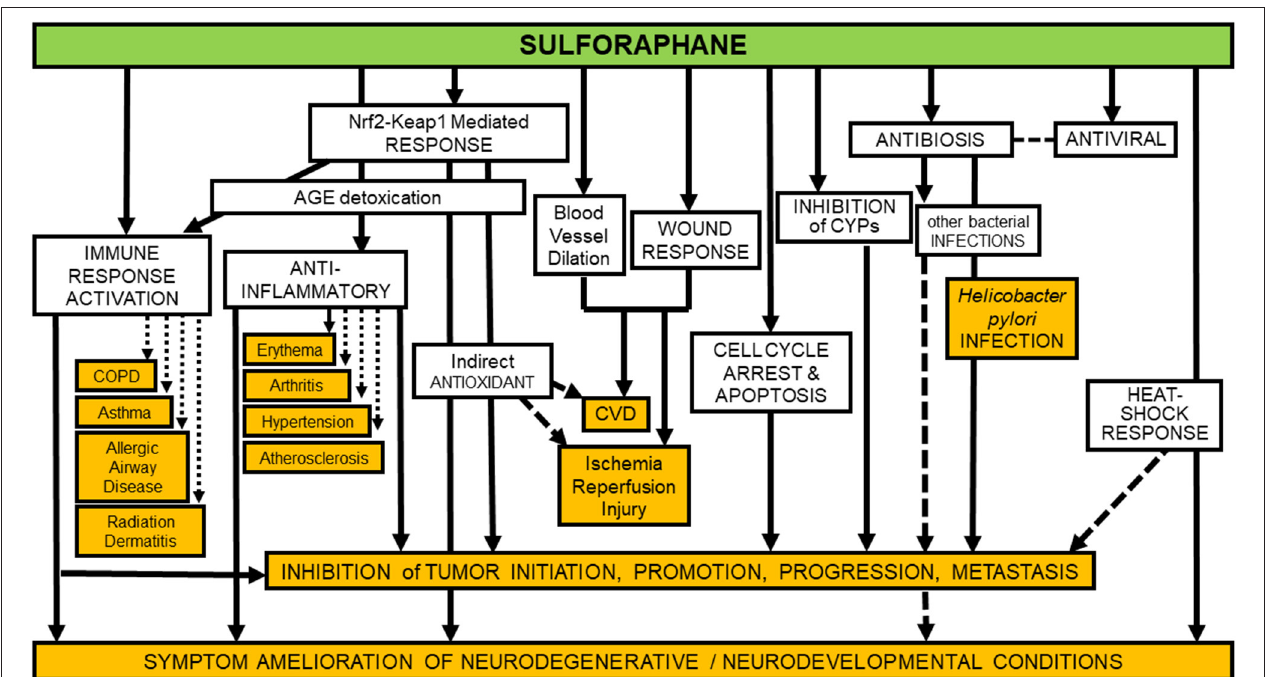
FIGURE 3 | Identified preventive and protective molecular mechanisms of sulforaphane are manifold. Unfilled boxes show some of the more robustly documented mechanisms, whereas orange-filled boxes indicate some of the more well-documented diseases, syndromes, and conditions against which sulforaphane’s efficacy has been assessed in clinical, animal, and in-vitro studies. Mechanisms involved in inhibition of tumor initiation, promotion, progression and metastasis (second box from bottom of figure) are too numerous to fully itemize on a simplistic diagram such as this, but in addition to those indicated by arrows directed toward the box, they include: inhibition of NF κ B, HDACs, Pgp, MRP-1, BCRP, STAT3, MEKK1 activity, AP-1 DNA binding, and tubulin polymerization; degradation of α and β -tubulin; down-regulation of cyclin B1, cdk1, cdc25B, cdc25C, HIF, VEGF, VEGF receptor, MMP-2, and MMP-9; modulation of Bcl-2 family proteins; and activation